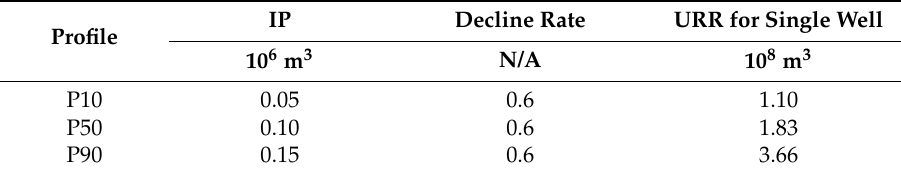
Table 1. Production class and well performance for Fuling field.